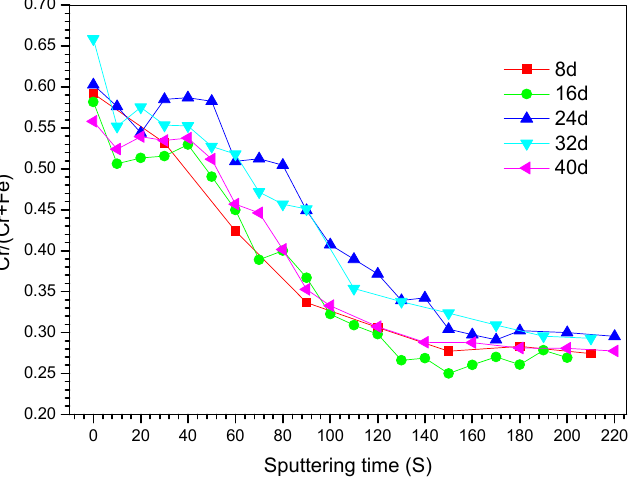
Figure 8. Fraction of Cr/(Cr+Fe) ratio in the passive films as a function of sputtering time. The deconvolution results from the XPS analysis indicated that the passive film mainly consisted of Cr and Fe oxides/hydroxides. The outer and inner layers had similar Fe components composed of Fe 2 O 3 /FeOOH and FeO. However, the outer and inner layers had different Cr components. CrO 3 , Cr 2 O 3 /Cr(OH) 3 was the primary oxidized species in the outer layer, whereas Cr 2 O 3 , Cr(OH) 3 was the primary oxide in the inner layer of the passive film from the XPS peaks.